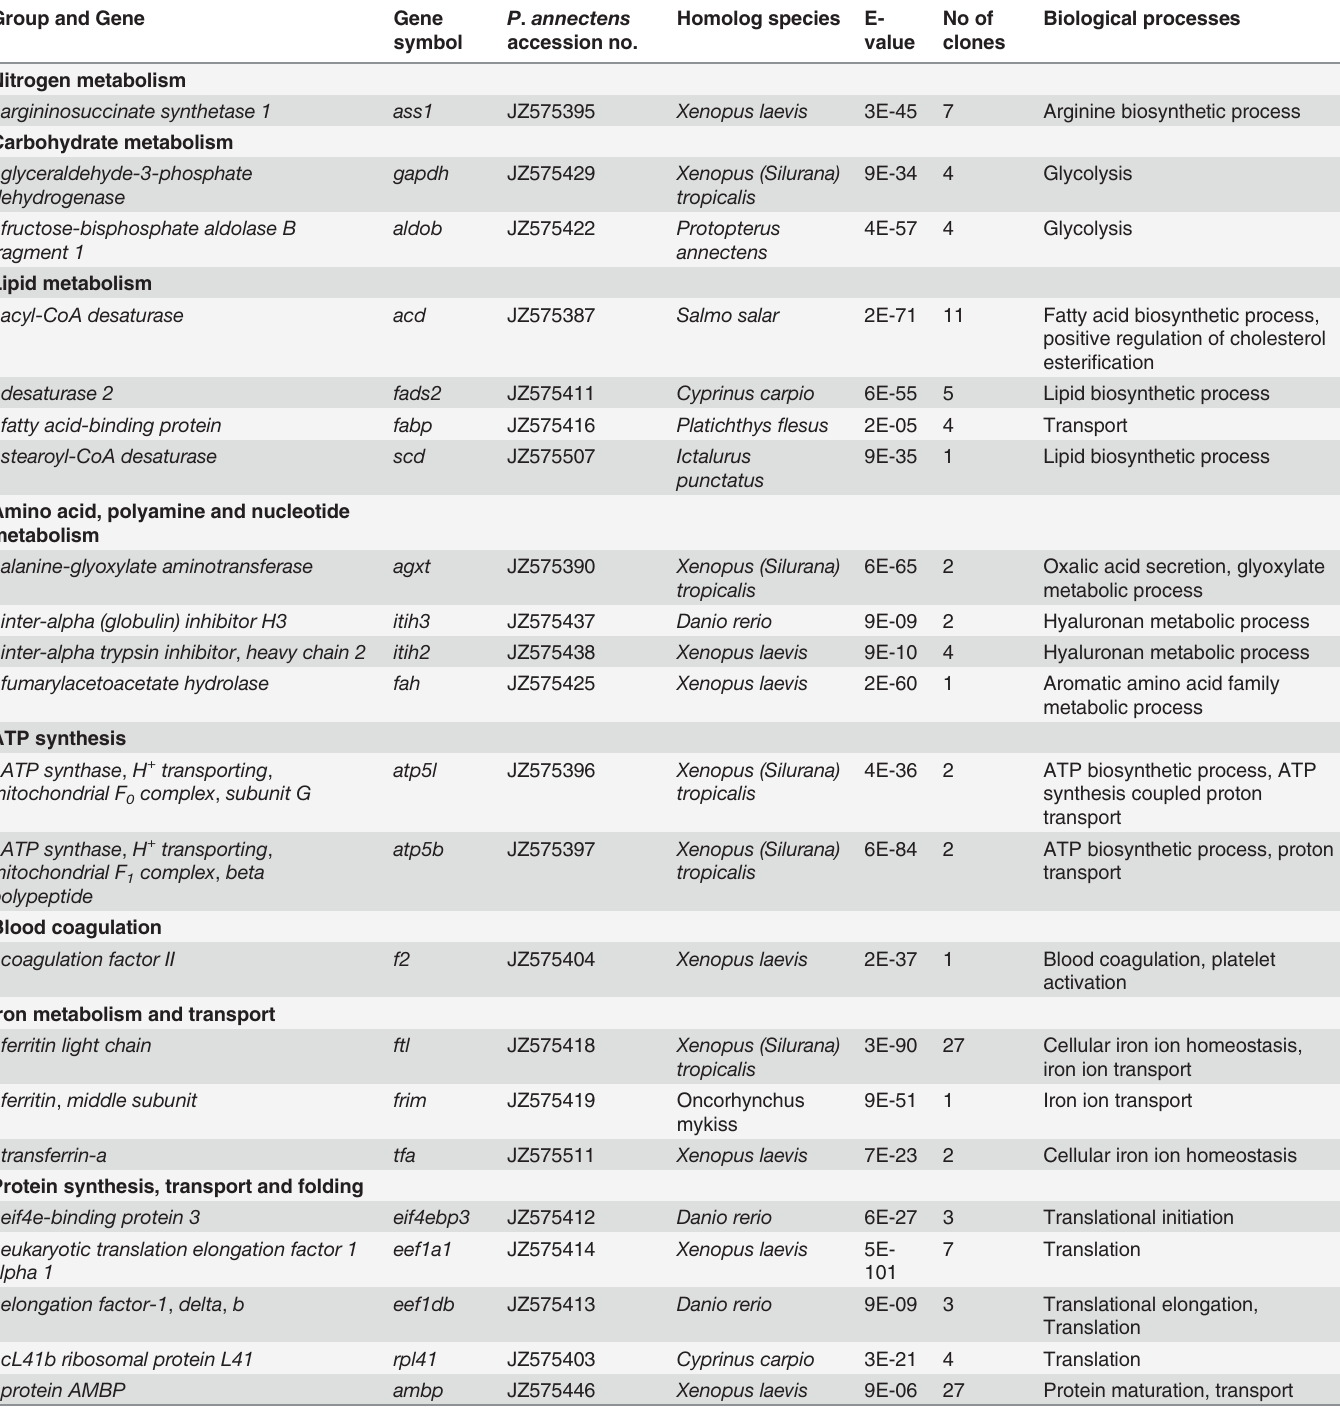
Table 4. Known transcripts found in the forward library (up-regulation) obtained by suppression subtractive hybridization PCR from the liver of Protopterus annectens after 1 day of arousal from 6 months of aestivation with fi sh aestivated for 6 months in air as the reference for